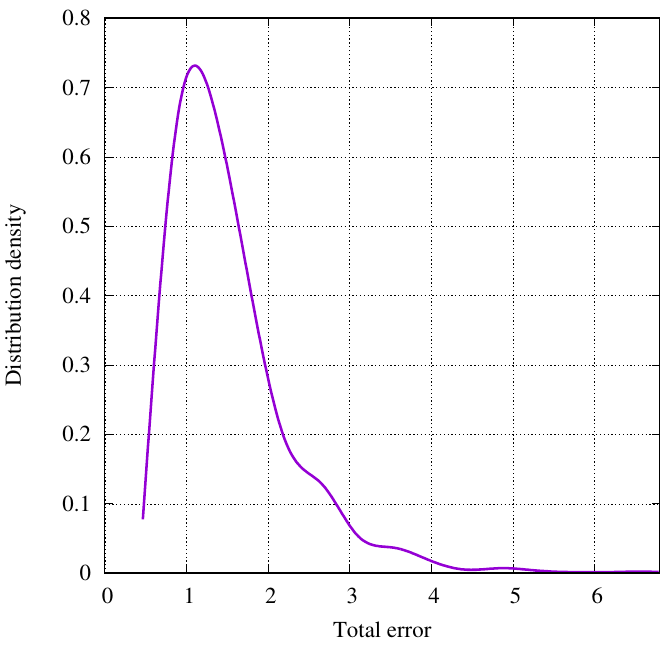
Figure 14. Distribution of the total error, Equation